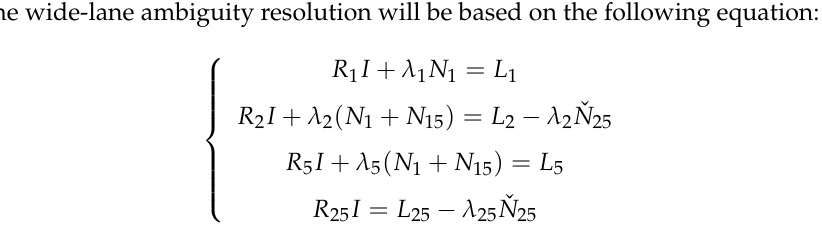
Figure 18. Extra-wide lane ambiguity minus correct integer ambiguity (GPS).